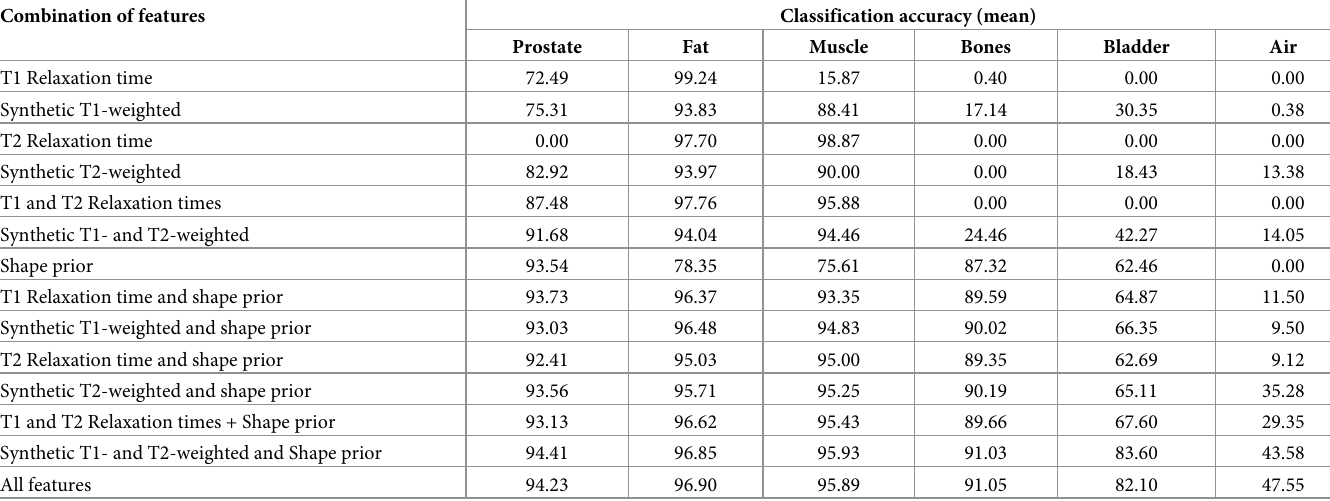
Table 1. Classification accuracy.